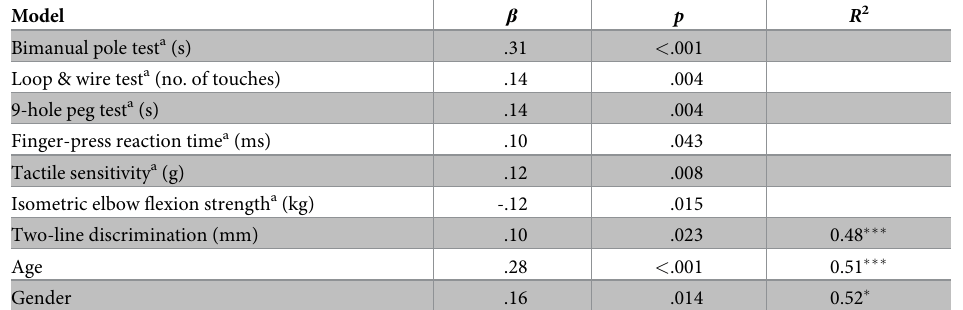
Table 9. Hierarchical multiple regression of performance in the shirt task a , showing standardised Beta weights, and R 2 after entry of each successive block of variables into the model. Model